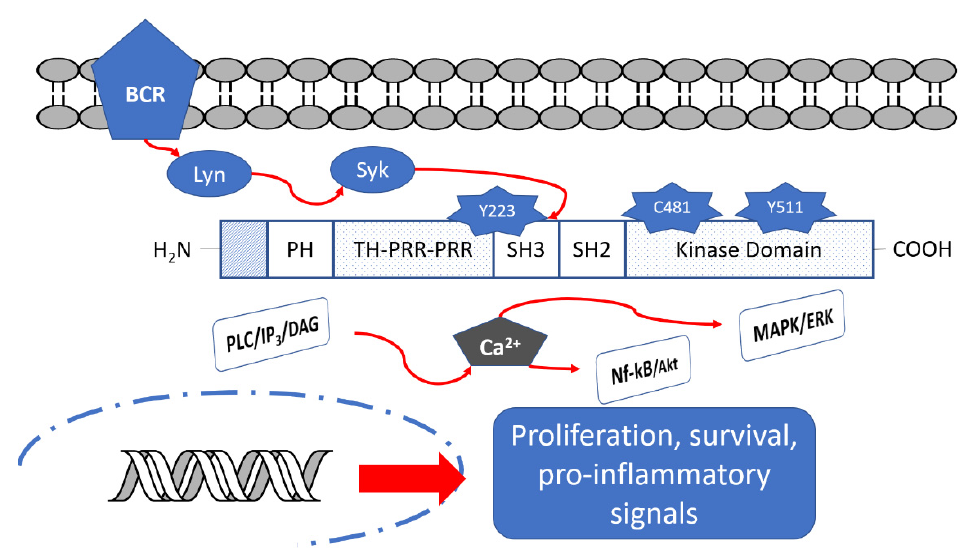
Figure 1. Btk structure and its down-stream signaling pathways.